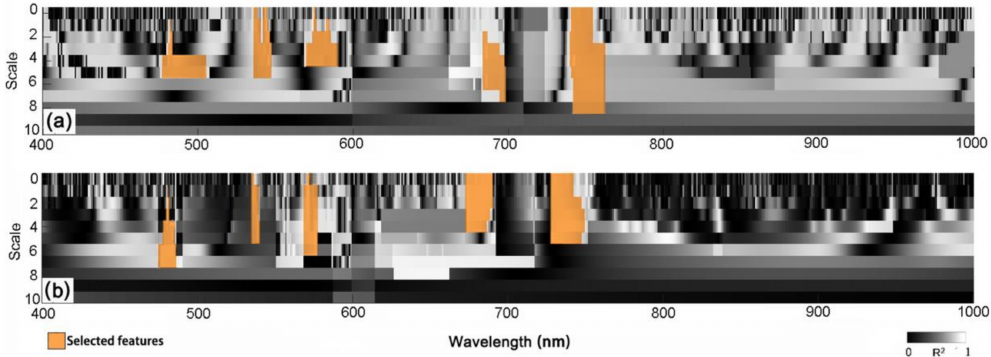
Figure 4. Correlation scalogram of continuous wavelet analysis for WRSFs extraction from ( a ) ASD and ( b ) Headwall dataset. This scalogram indicates the determination coefficients (R 2 ) between wavelet power and disease ration (DR). The highest 5% were highlighted in orange identifying wavelet feature